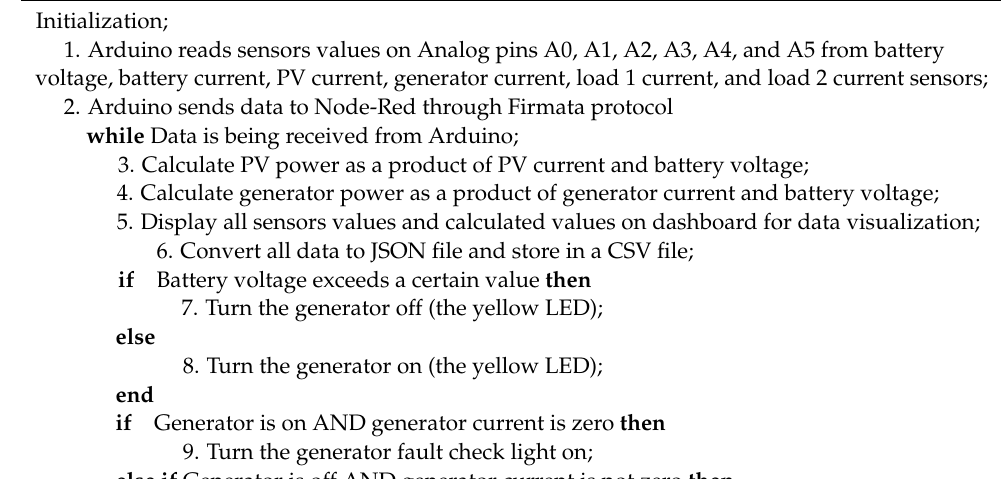
Algorithm 1: Data Acquisition and Control System Algorithm